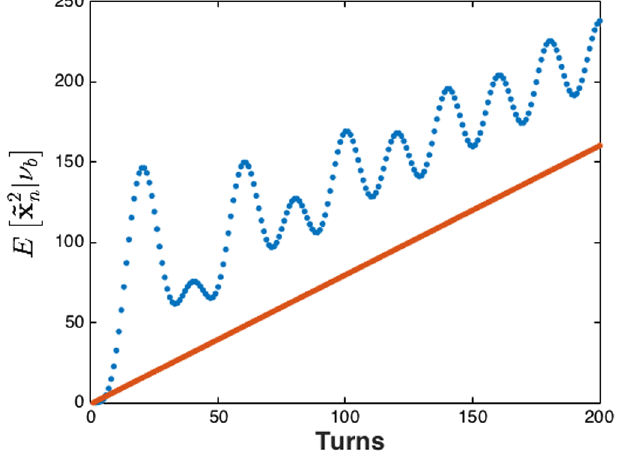
ν FIG. 2. E ½ ~ x 2 over the first 200 turns (blue dots) computed b (cid:3) n j from Eq. (10), compared to the linear trend of Eq.